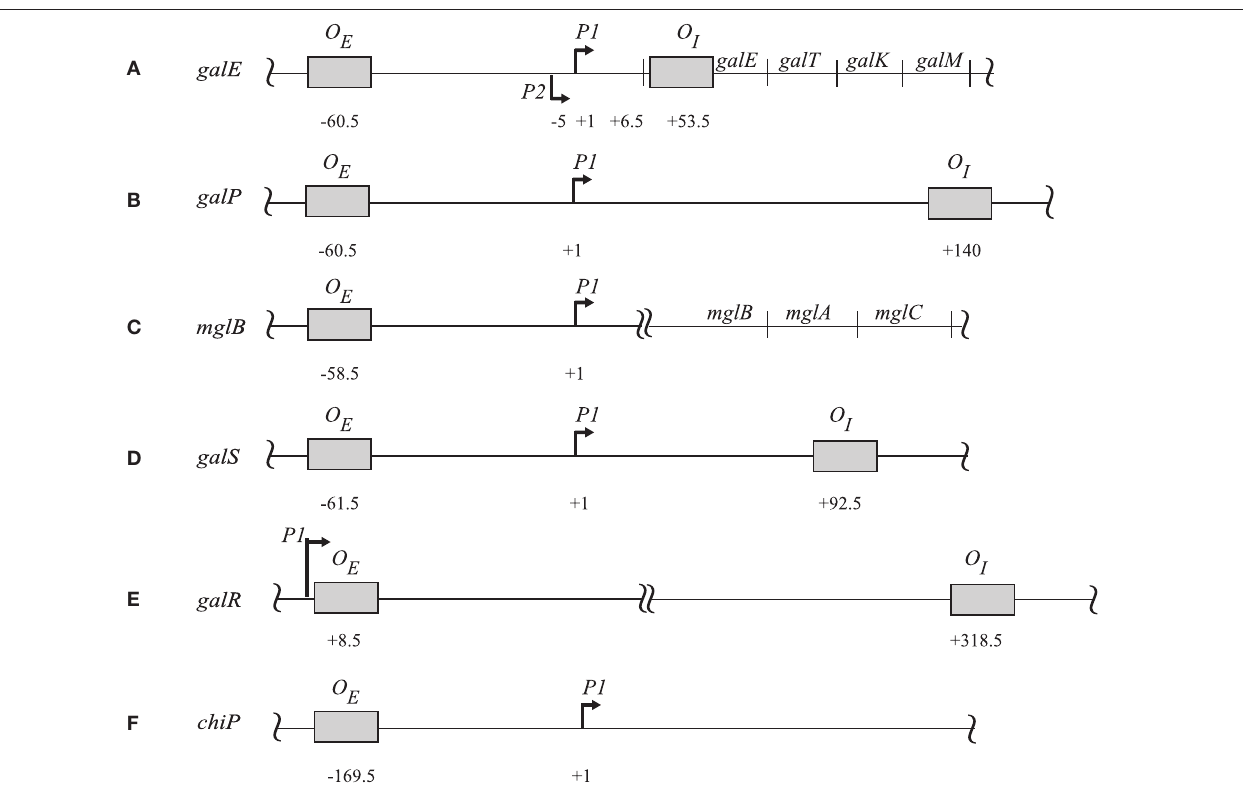
FIGURE 1 | The regulatory sites of (A) galE , (B) galP , (C) mglB , (D) galS , (E) galR , and (F) chiP operons. The operator sites in each operon are in shaded boxes with their locations relative to the corresponding tsp . For galE the tsps are indicated as ( + 1) for P1 and ( − 5) for P2. The amino terminus of the first protein in each operon is indicated by a double-arrow. The diagram is not drawn to scale (Hogg et al., 1991; Weickert and Adhya, 1993a,b; Plumbridge et al.,